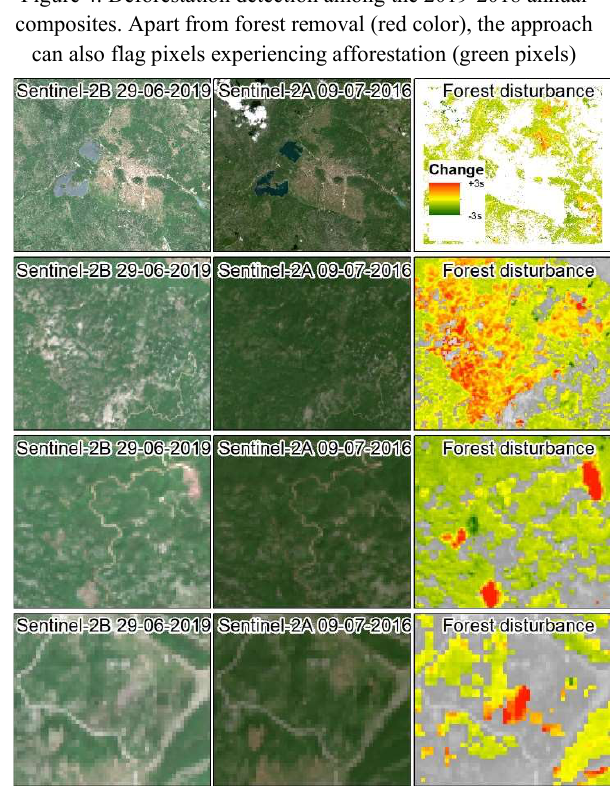
Figure 5. Deforestation detection based on the bi-temporal analysis of two single scenes acquired on 09-07-2016 and 29- 06-2019. Both small-scale and large deforestation events (yellow to red) are